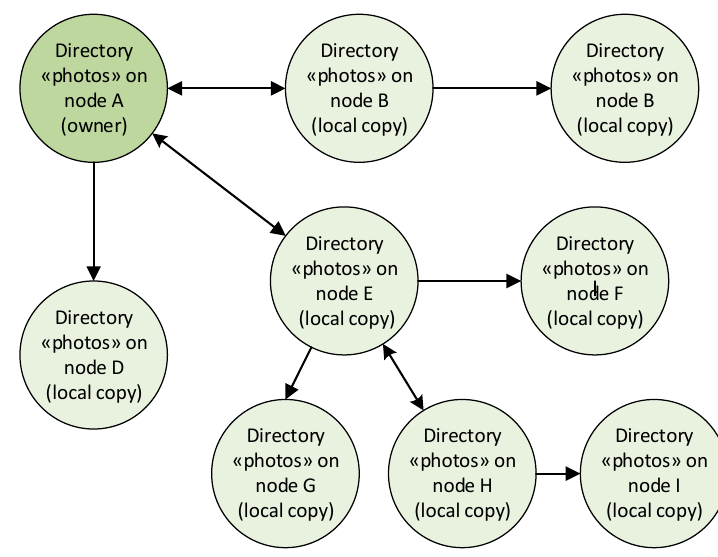
Figure 3. Multilateral synchronizations: complex synchronization trees.